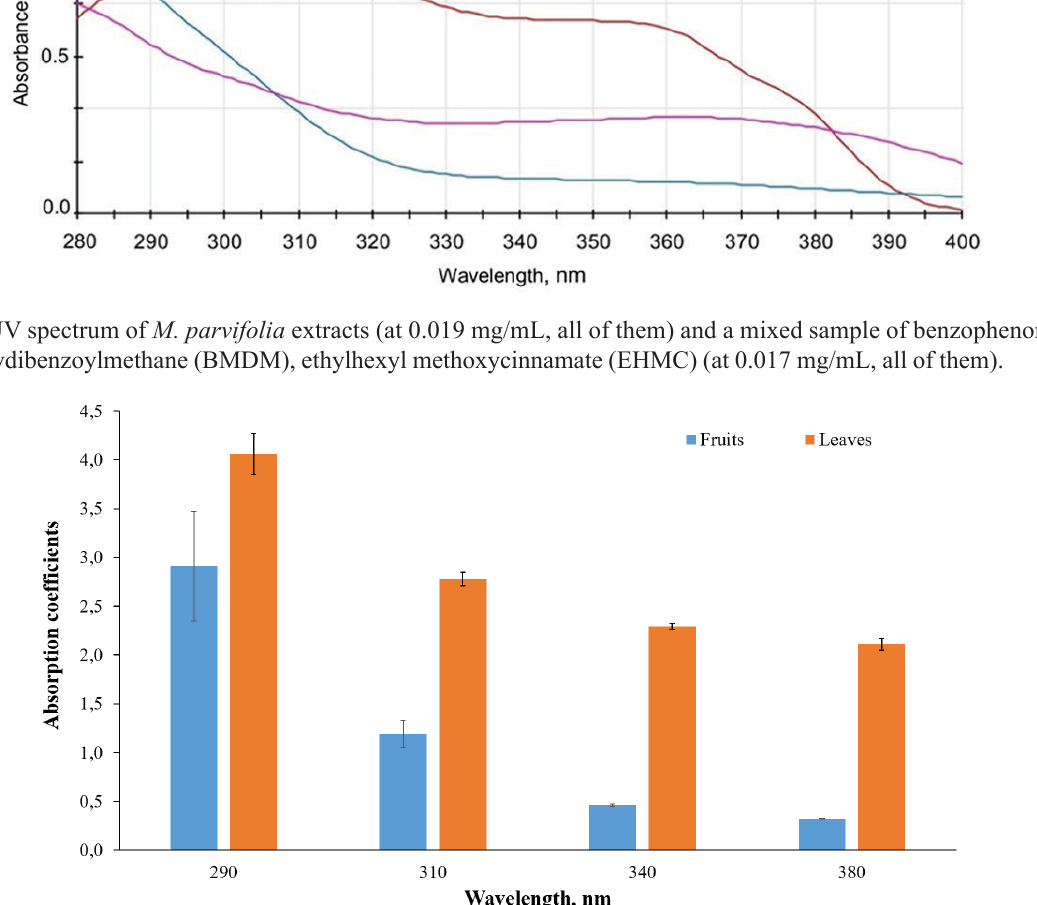
FIGURE 2 - UVA-UVB absorption coefficient (absorbance/ mg DS x mL) at 290, 310, 340 and 380